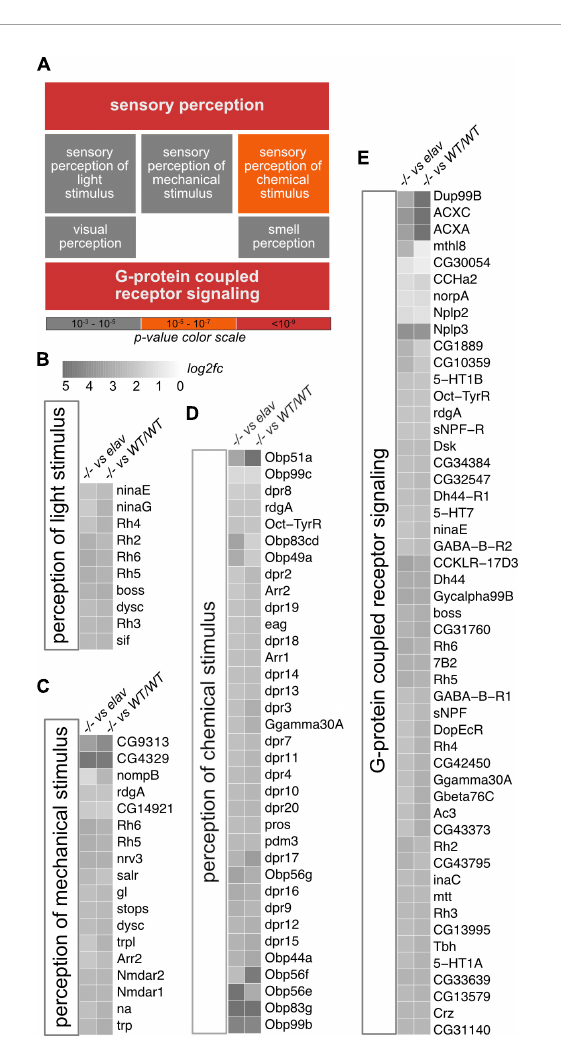
FIGURE1 Gene ontology (GO) enrichment analysis of upregulated genes in Chd1 − / − heads. (A) Significantly enriched GO terms from the analysis of 1897 genes that were upregulated in Chd1 − / − versus Chd1 WT / WT as well as Chd1 − / − versus Chd1 elav (log2 fold change ≥ 1, adjusted p ≤ 0.05, base mean ≥ 20). Color code signifies significance of enrichment as indicated. (B–E) Heatmaps of differentially regulated genes in enriched categories. Color scale in panel B , indicating log2 fold change ( log2fc ), applies to all